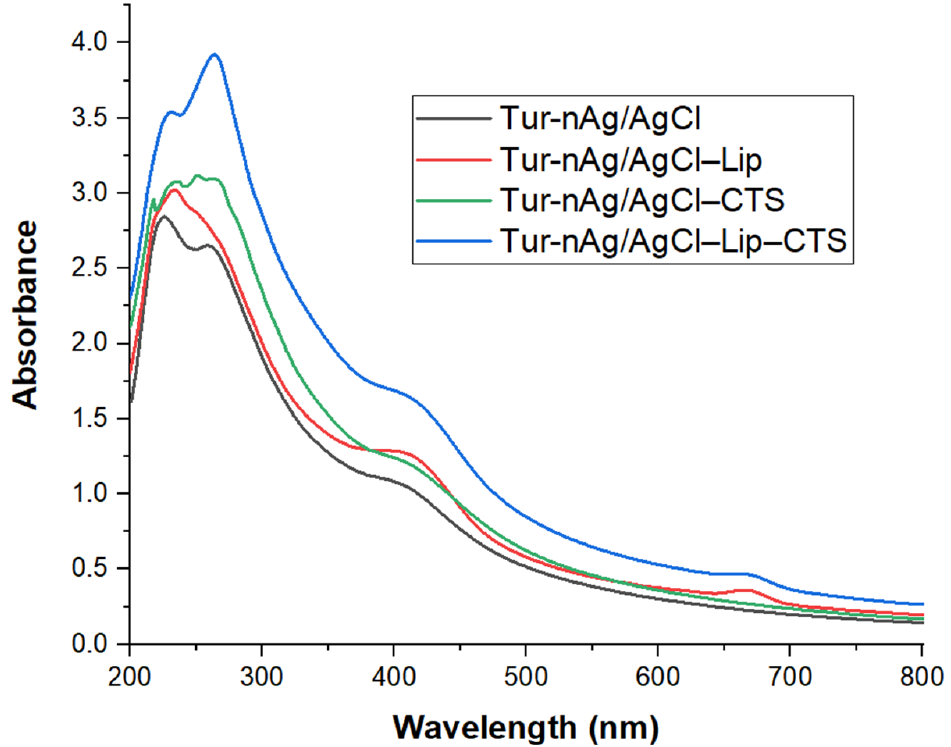
Figure 1. UV-Vis absorption spectra of silver-containing